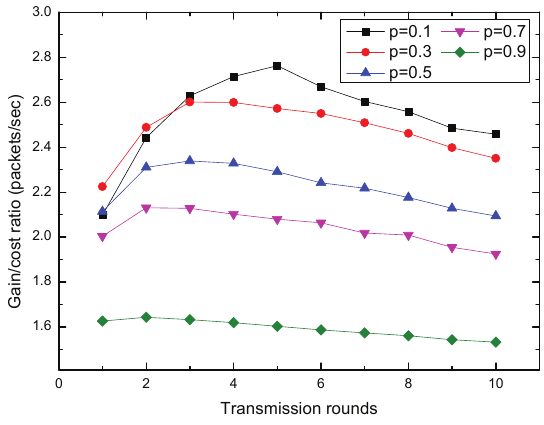
Figure 11. Tradeoff between completion time and information gain.